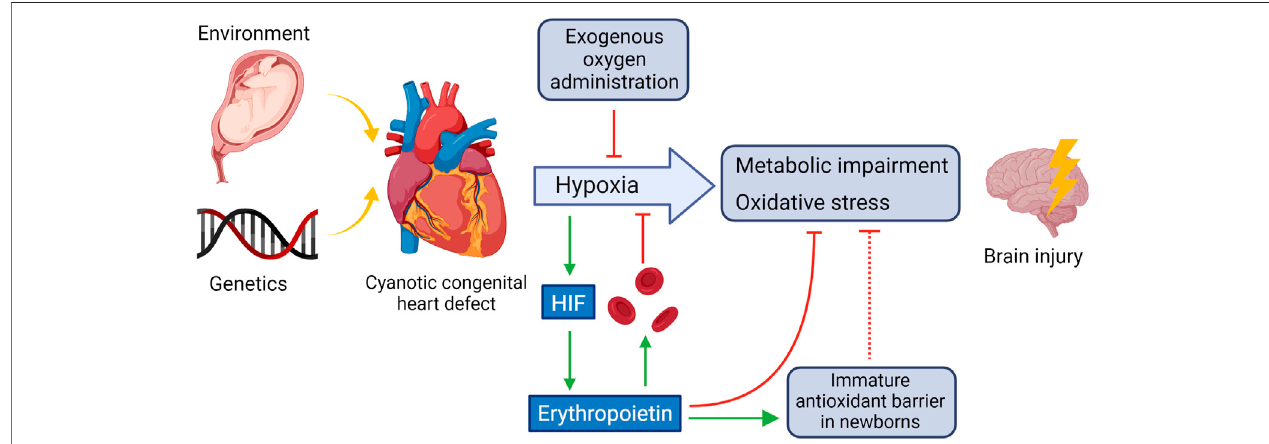
FIGURE1| CHD-inducedoxidativeandhypoxicdamageinthebrainandpotentialcounteractivemechanisms.HIFactivatedbyhypoxemiatriggers,amongothers, the synthesis ofEPO which stimulates red blood cell production, inpart byinhibiting apoptosis ofthe red blood cell precursors and helps tocounteractsoxidativestress in the brain by strengthening the immature antioxidant barrier. Created using